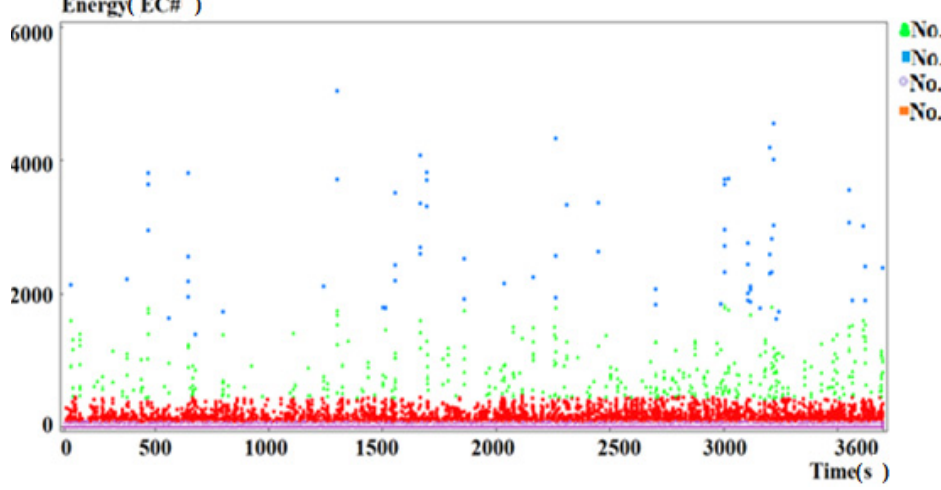
Figure 20. Energy versus time for the second measurement period—October 2016. Appl. Sci. 2018 , 8 , x